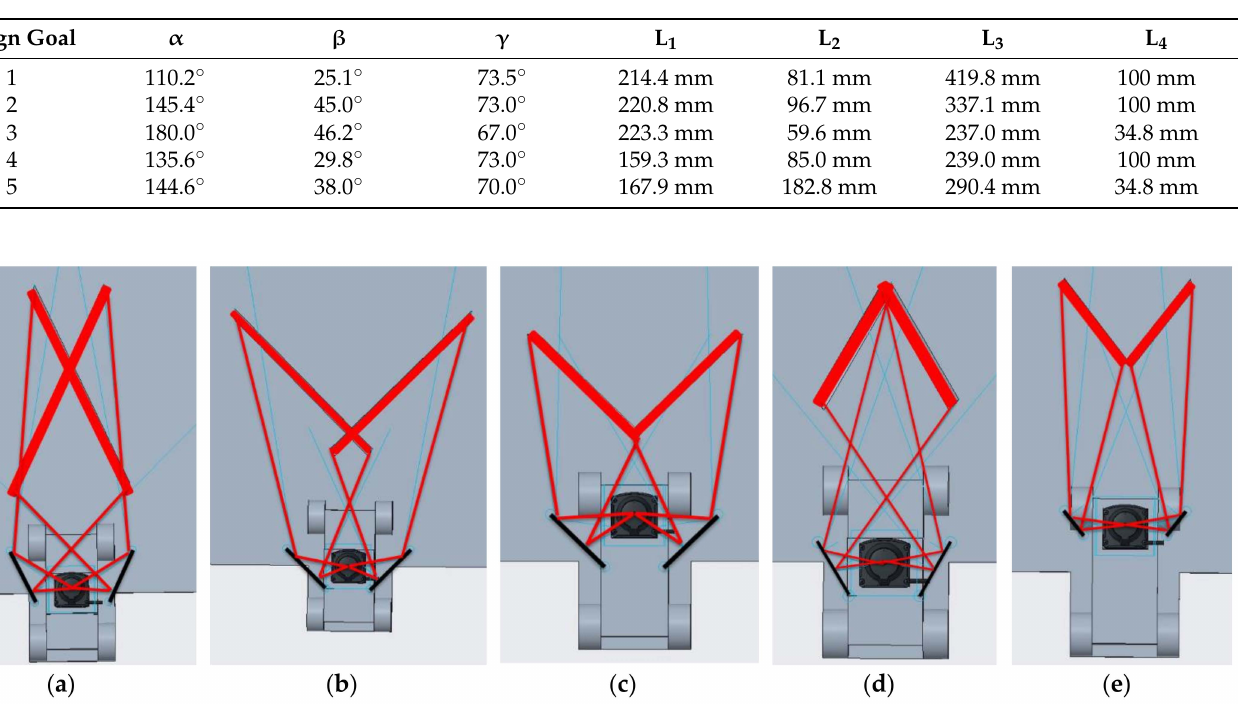
Table 3. Resulting geometry parameters for typical CADs aiming for each of the five different design goals. (See Figure 3 for definitions of the used geometry parameters.).